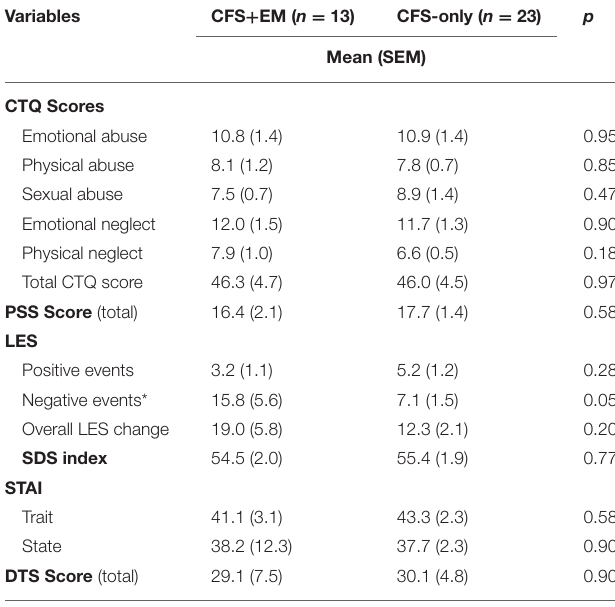
TABLE 3 | Comparisons of psychometric variables in women with CFS by subgroup—with and without endometriosis.